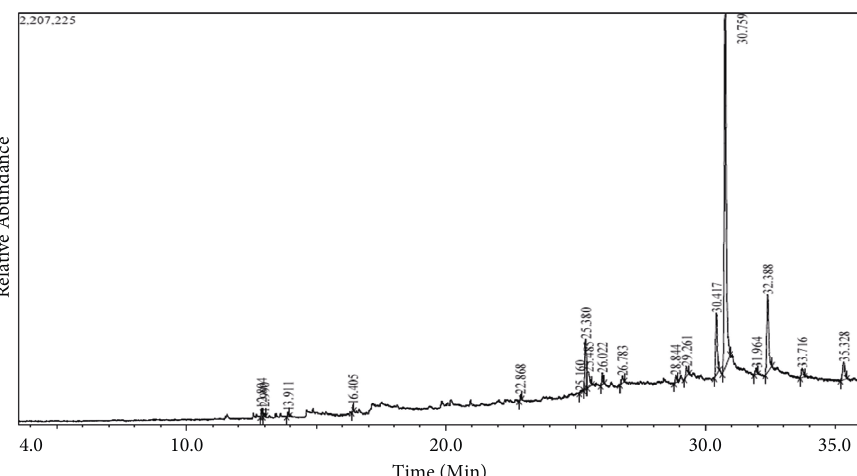
Figure 3: GC-MS chromatogram of methanolic extract of P . ostreatus mushroom cultivated from sugar cane substrates supplemented with various levels of wheat bran.